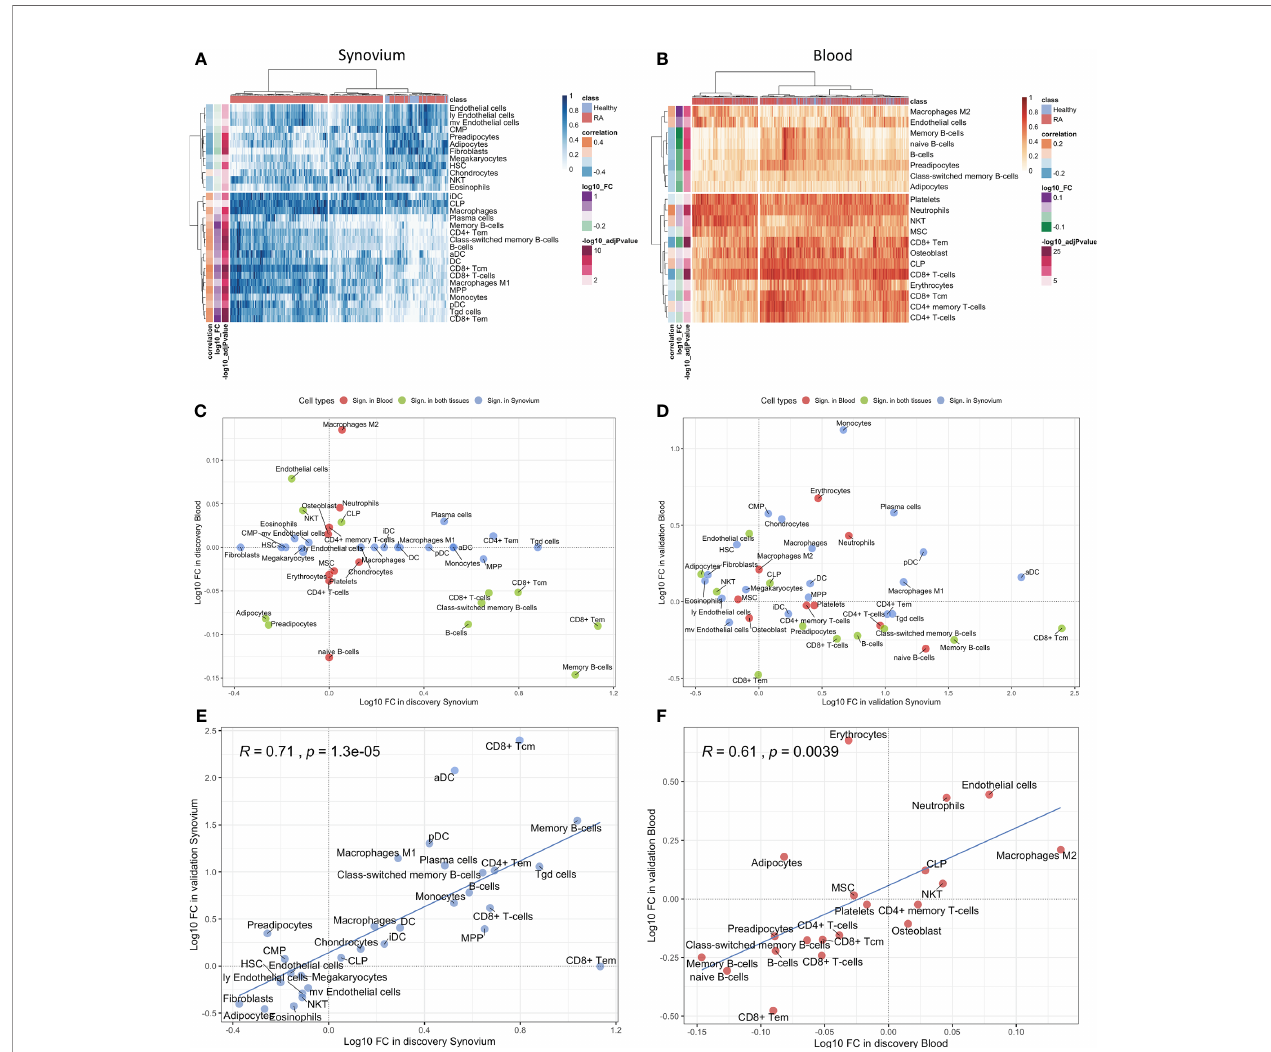
FIGURE 3 | Cell type enrichment analysis for synovium and whole blood tissues. 30 cell types were signi fi cant (BH adj p-values < 0.05) in synovium and 20 were signi fi cant in whole blood with 11 common cell types between the tisuues. Heatmap plots of signi fi cantly enriched cell types in (A) synovium and (B) blood. The scatter plots comparing log10 transformed fold changes of signi fi cant cell types between synovium and blood in (C) discovery and (D) validation cohorts. The scatter plots comparing log10 transformed fold changes of signi fi cant cell types between discovery and validation cohorts in (E) synovium and (F) blood tissues, with Pearson correlation coef fi cient and it's